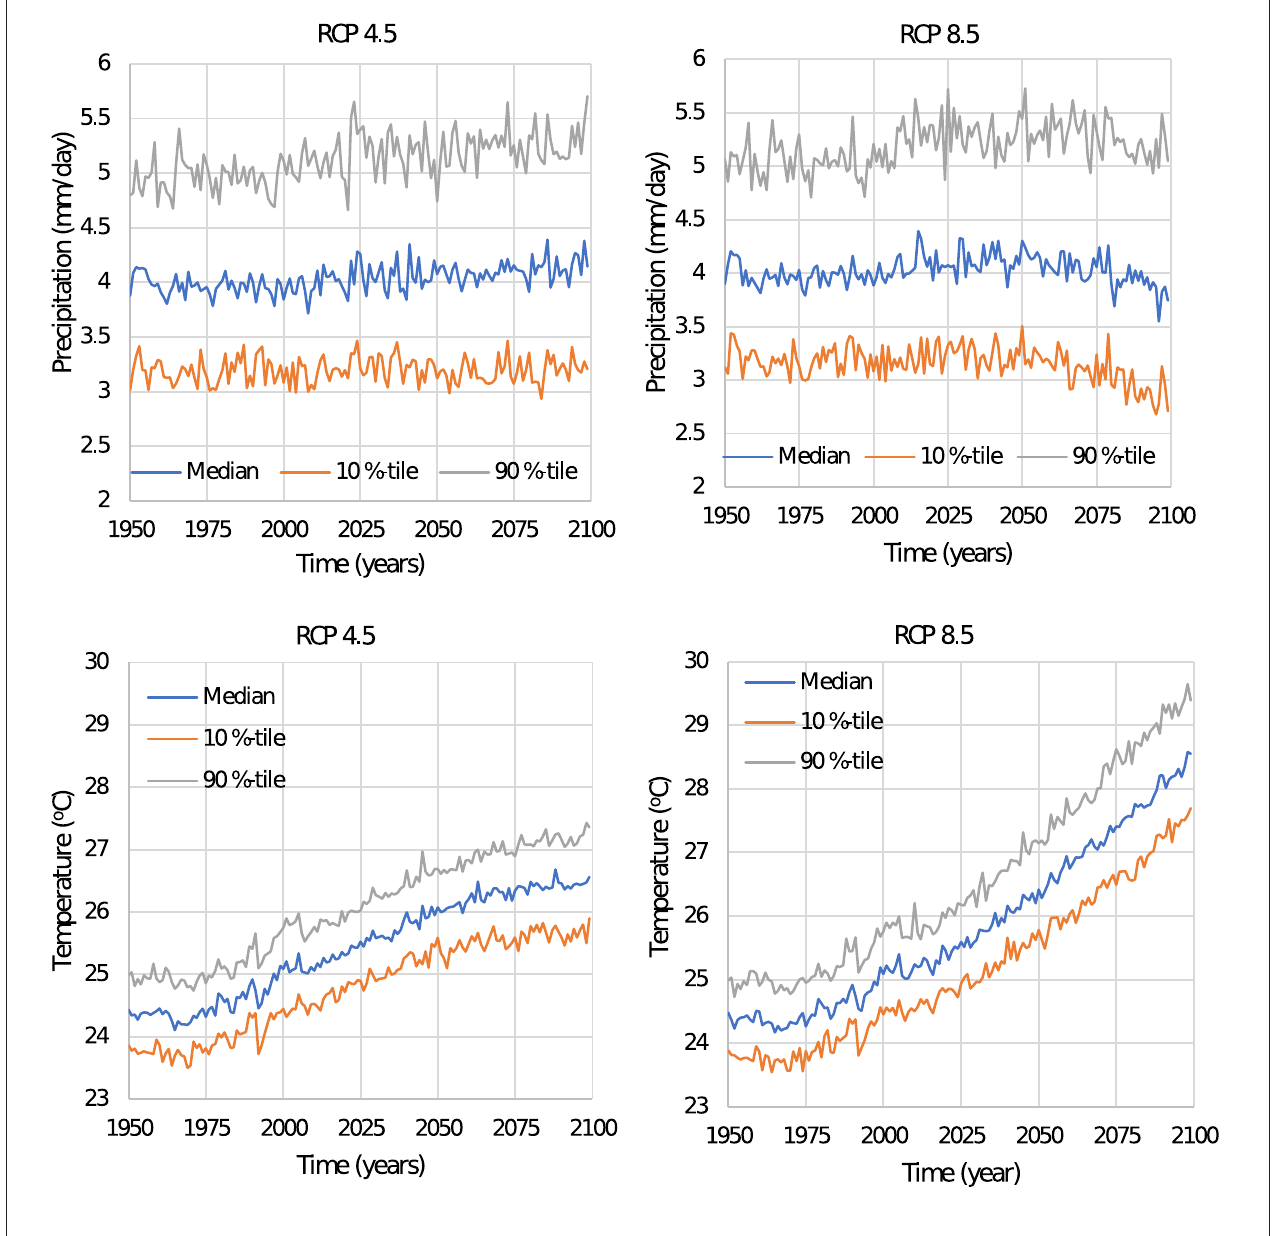
FIGURE 1 | Projected 10 percentile, median, and 90 percentile values of precipitation and temperature for